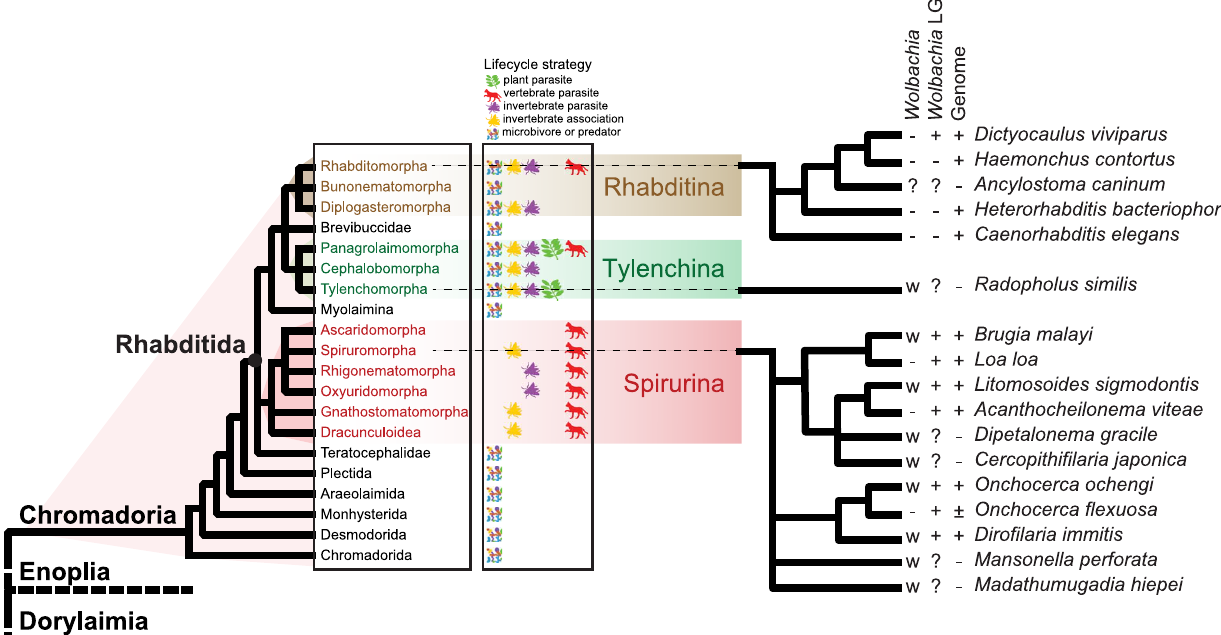
Figure 1. Relationships of nematode species harbouring Wolbachia symbionts. A phylogenetic cartoon showing the relationships of the nematode species discussed in this work [23]. To the left, the systematic structure of the class Chromadoria is given, and the three major suborders within Rhabditida are highlighted. Lifecycle strategies of the groups are indicated. The fine-scale relationships of species discussed in the text are given to the right. The presence of live Wolbachia infection ( + : yes, 2 : no), evidence of laterally-transferred Wolbachia sequences in the nuclear genome ( + : yes, 2 : no, ?: unknown), and the availability of complete genome sequences ( + : yes, 2 : no, 6 : partial genome sequence) for each of the species are